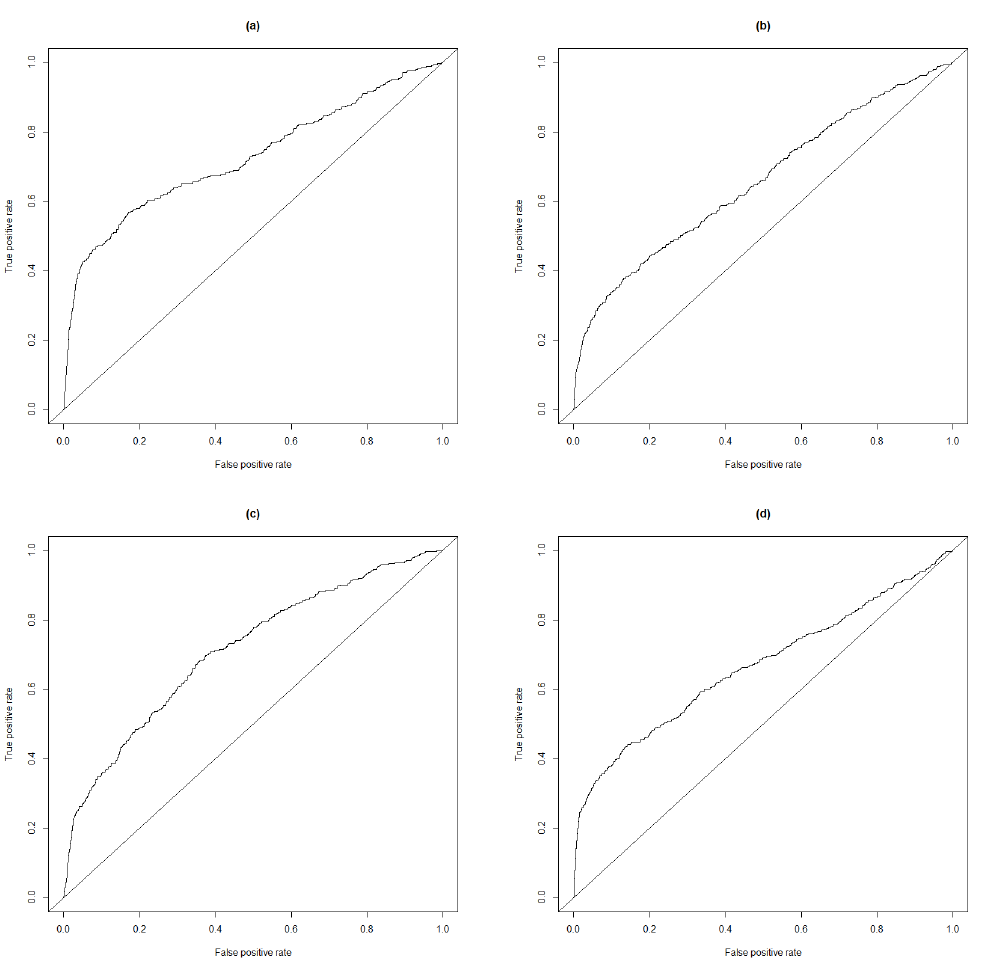
Figure 4. ROC curves for 4 different anomaly scores: ( a ) uses average bottleneck distance percentile when sorted by day of week; AUC = 0.72526. ( b ) uses standard deviation bottleneck distance percentile when sorted by day of week; AUC = 0.65658. ( c ) uses median bottleneck distance percentile when sorted by day of week; AUC = 0.71332. ( d ) uses the standard normal deviations; AUC = 0.66754.